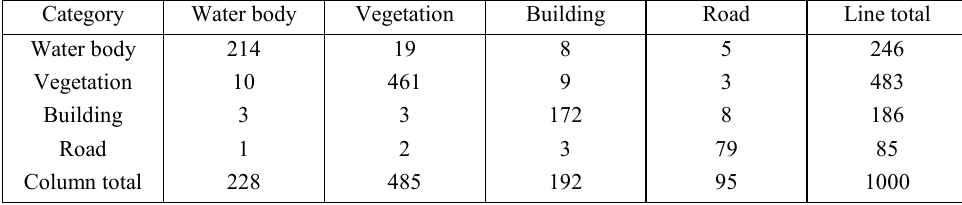
Table 4. SegNet classification obfuscation